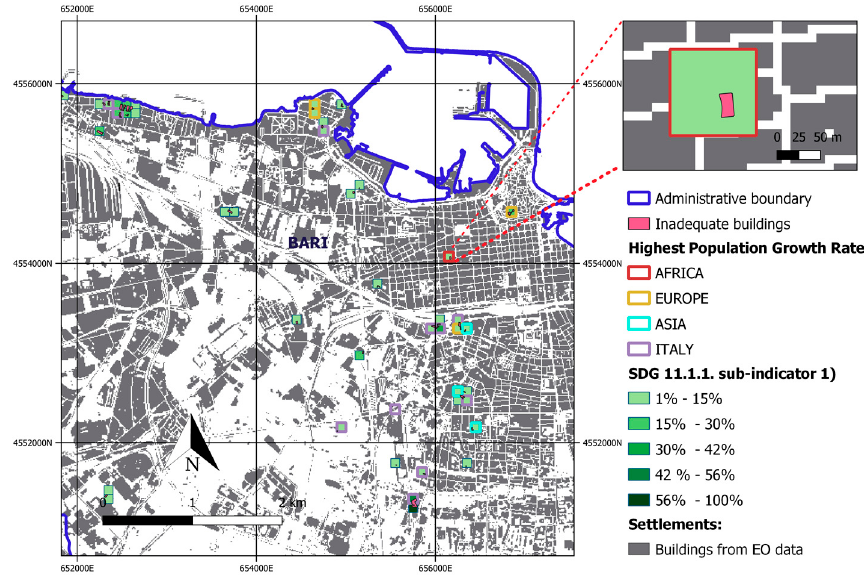
Figure 18. SDG 11.1.1 sub-indicator (1) Proportion of households with non-durable housing.